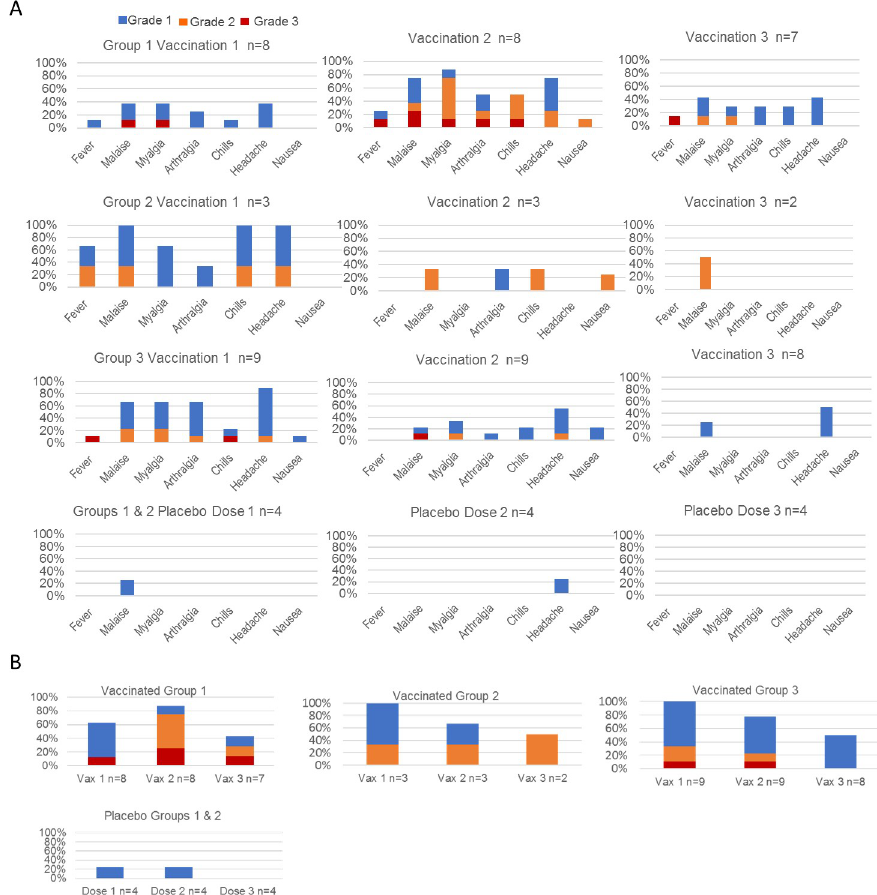
Fig 2. Vaccination phase AEs in vaccinated and placebo control participants. ( A ) Specific solicited systemic AEs shown as the proportion of subjects who reported a maximum grade of 3, 2, or 1 in the 7–10 days after each vaccination by group and vaccination status. ( B ) The proportion of participants in each group and amongst placebo controls who reported at least one Grade 3, Grade 2 (Grade 3 excluded), or Grade 1 (Grades 2–3 excluded) event by dose. Grade 1 events are those that required minimal or no treatment and did not interfere with daily activities. Grade 2 events are those that resulted in a low level of inconvenience or required therapeutic measures and may have interfered with functioning and daily activities. Grade 3 events are those that interrupted the subject’s usual daily activities. Temperature values are noted only if � 38.0˚C (lower limit of graded fever) and are reported as Grade 1 (38.0˚C—38.4˚C), Grade 2 (38.5˚C—38.9˚C), or Grade 3 ( > 38.9˚C). Vomiting was a solicited systemic adverse but was not reported by any subject in the 7- to 10- days after a vaccination and so is not represented in the graphs. Blue fill (top), Grade 1; orange fill (middle), Grade 2; red fill (bottom), Grade